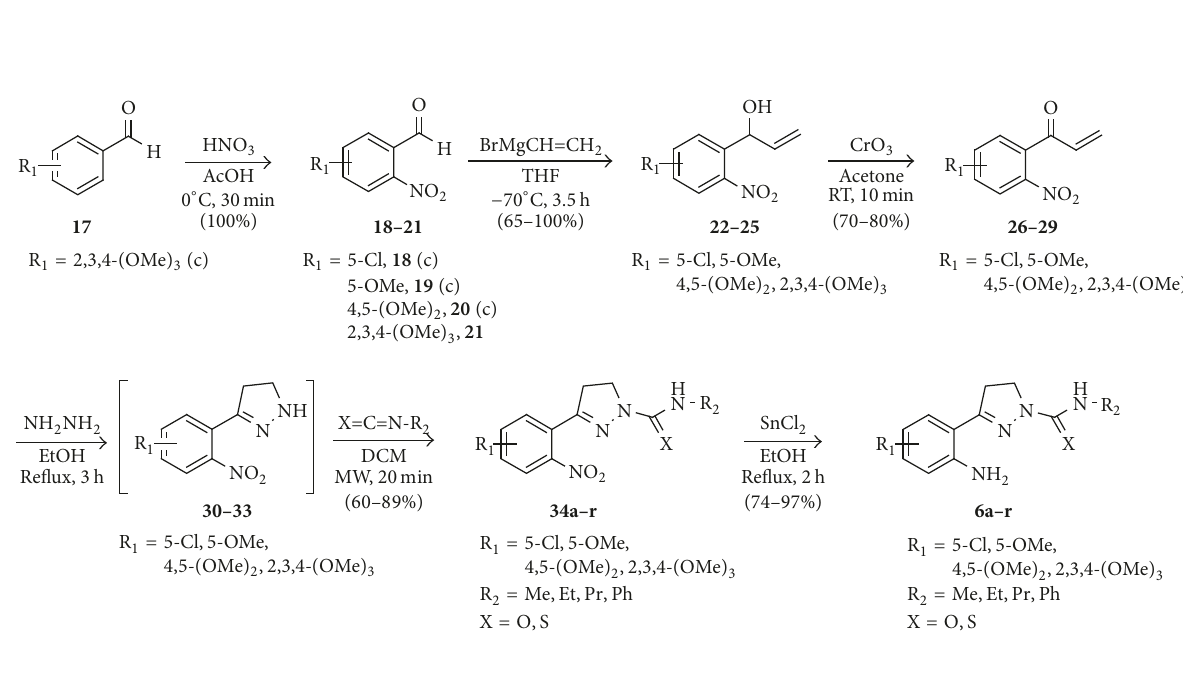
Scheme 1: Synthetic route of the final compounds (5a–e) .